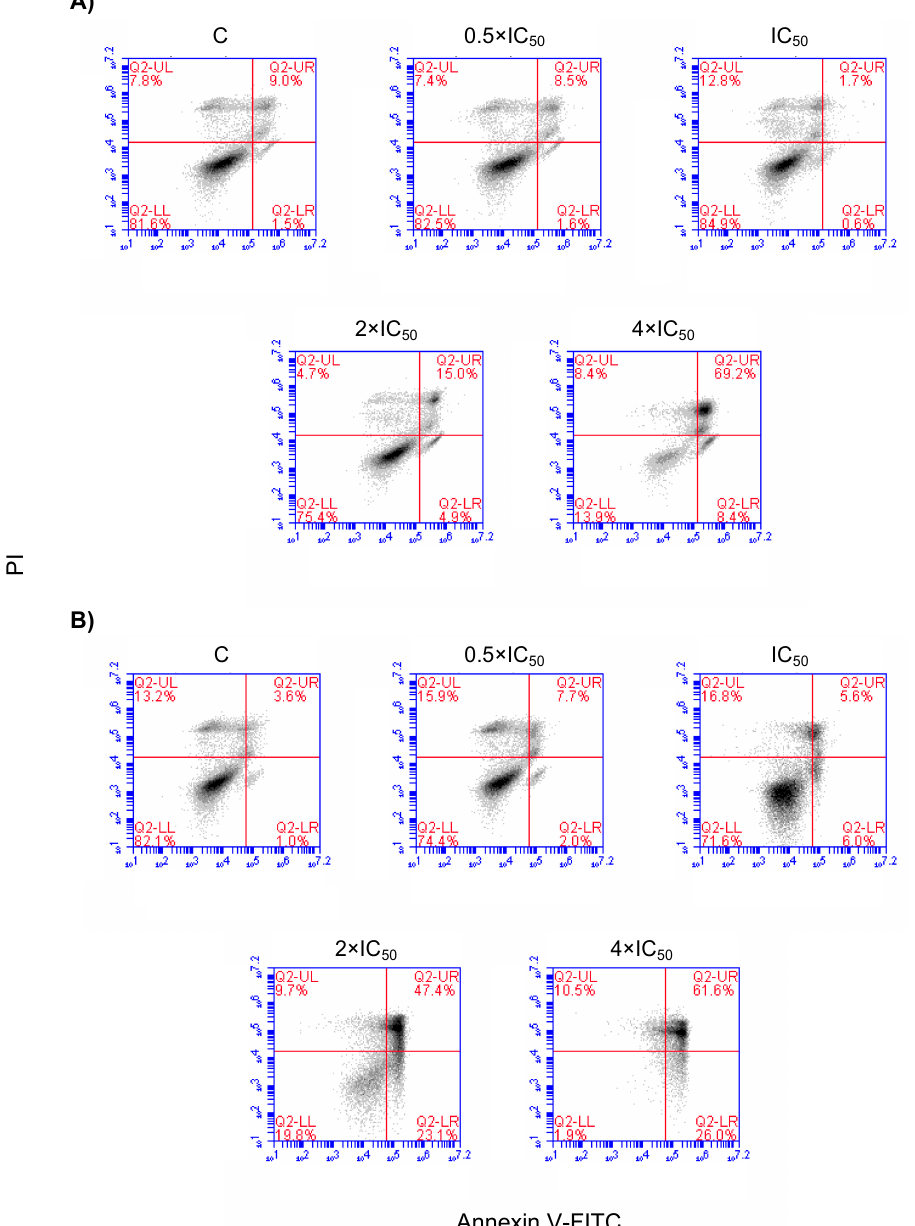
Figure 7. Apoptosis and necrosis effect in NCI-H929 cells treated with secalonic acid F (SAF) for 24 h ( A ) and 48 h ( B ).